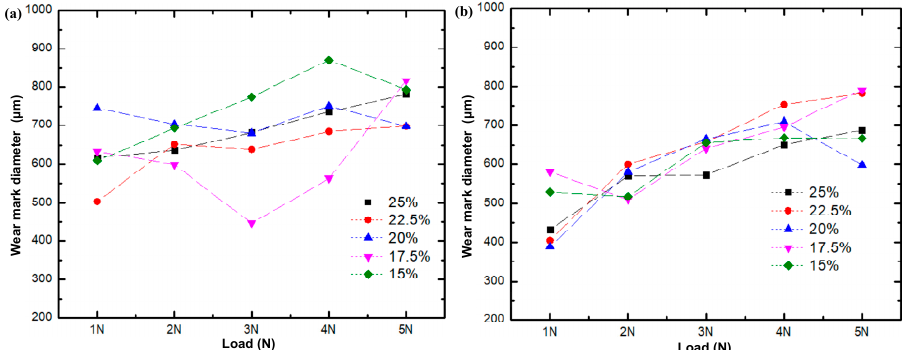
Figure 13. Variation of wear scar diameter of composites of different initial phase solid content with